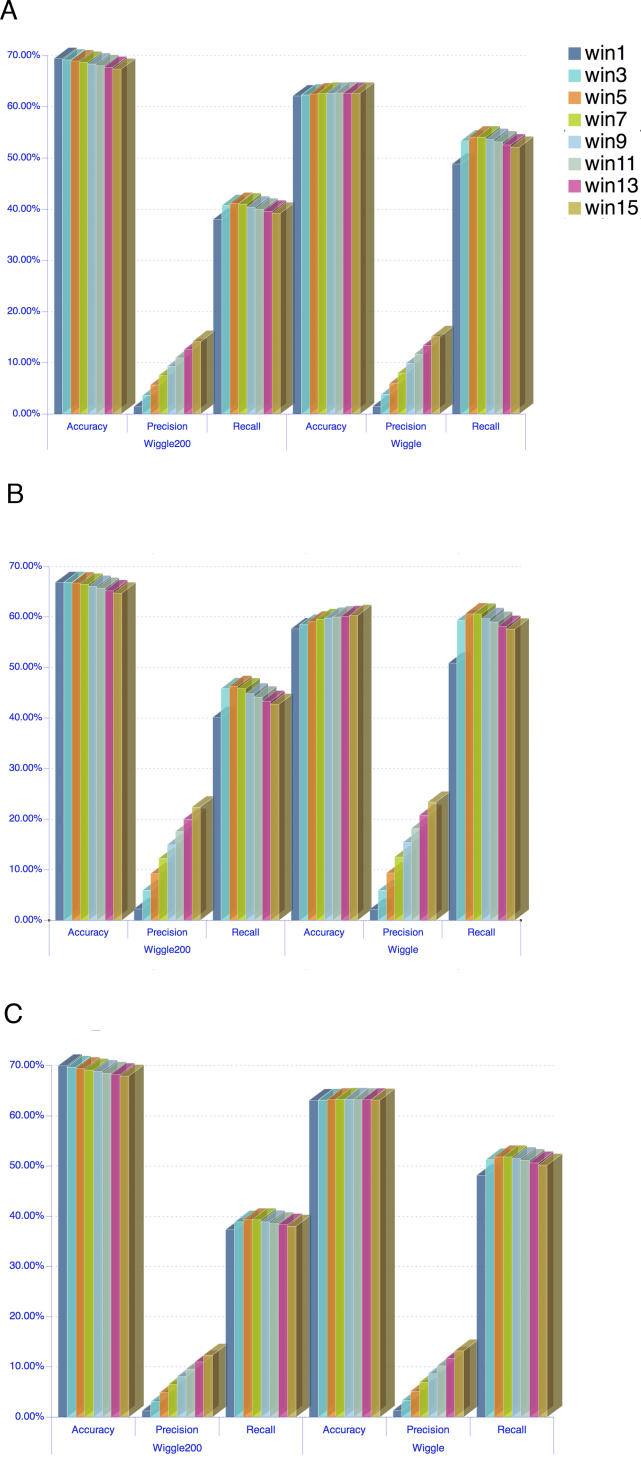
Predictor Performance in Identifying Domain BoundariesWiggle predictors were evaluated for domain boundary predictions on (A) a benchmark dataset containing domain boundary consensus between experts (BENCH), (B) a partitioned BENCH with proteins up to and including 200 residues (BENCHA), and (C) a partitioned BENCH with proteins longer than 200 residues. Definitions of domain boundaries were expanded up to a window size of 15 (win15) with the boundary in the center.